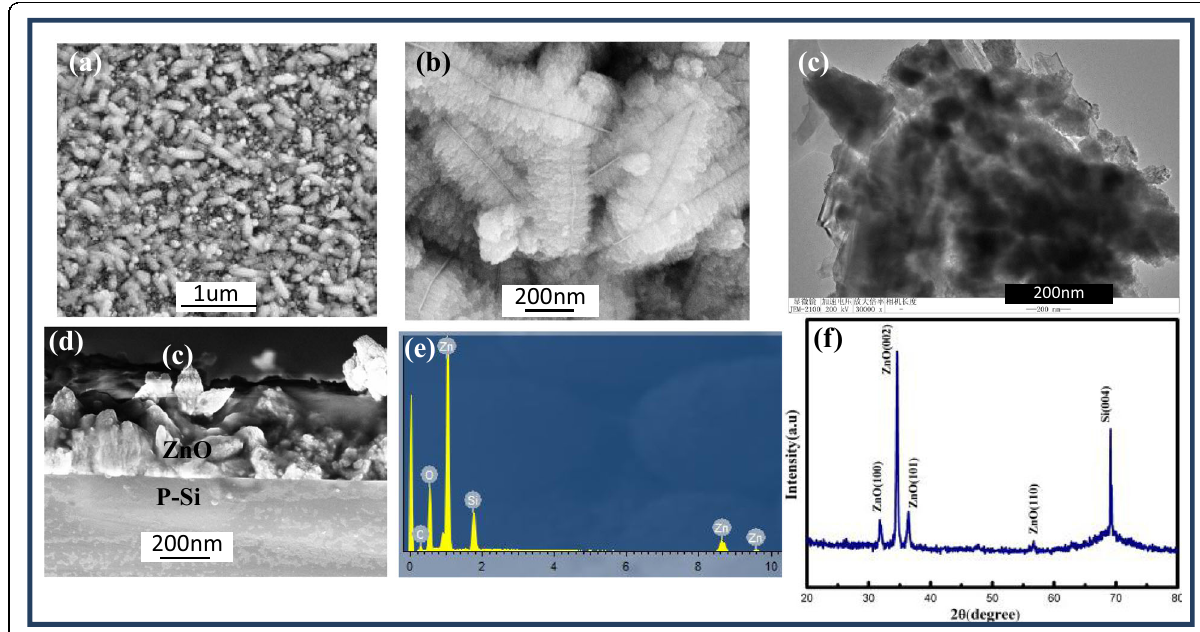
Fig. 1 a , b The SEM images of feather-like ZnO grown on silicon. c The TEM image of individual feather-like ZnO. d The cross-sectional SEM image of feather-like ZnO/p-Si. e The EDS analysis of the ZnO/p-Si, indicating that the predominant composition is Zn. f XRD patterns of feather-like